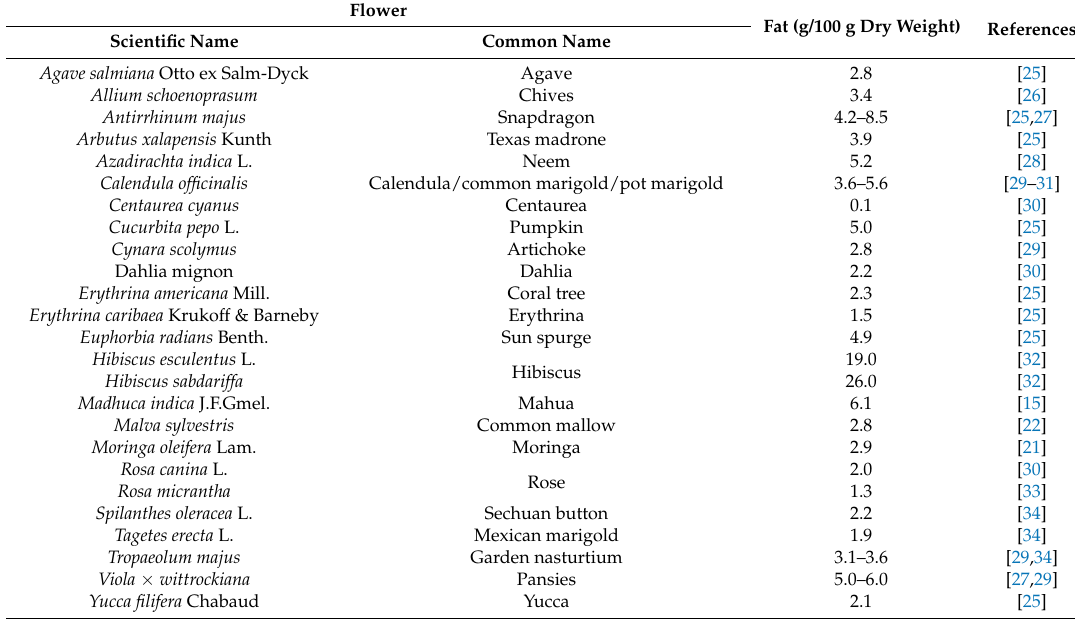
Table 1. Fat content (g/100 g dry weight) reported in the literature for some edible flowers. Flower